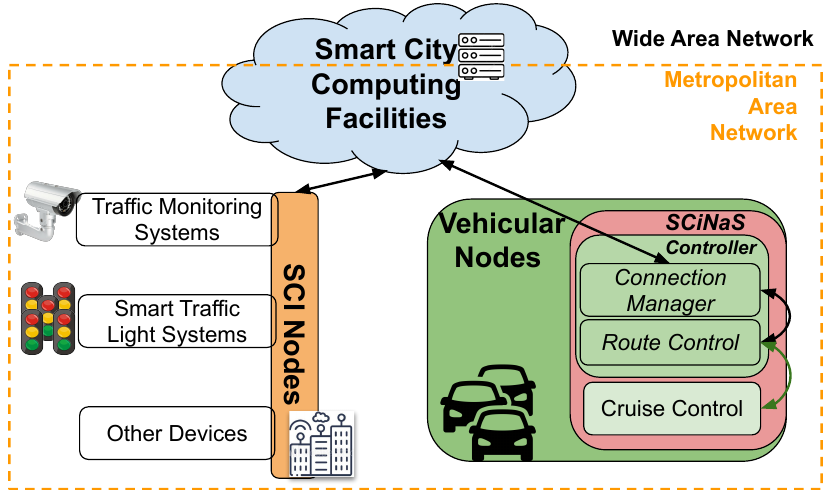
Figure 15. High-level view of cooperation among CPSs in SCiNaS [47].